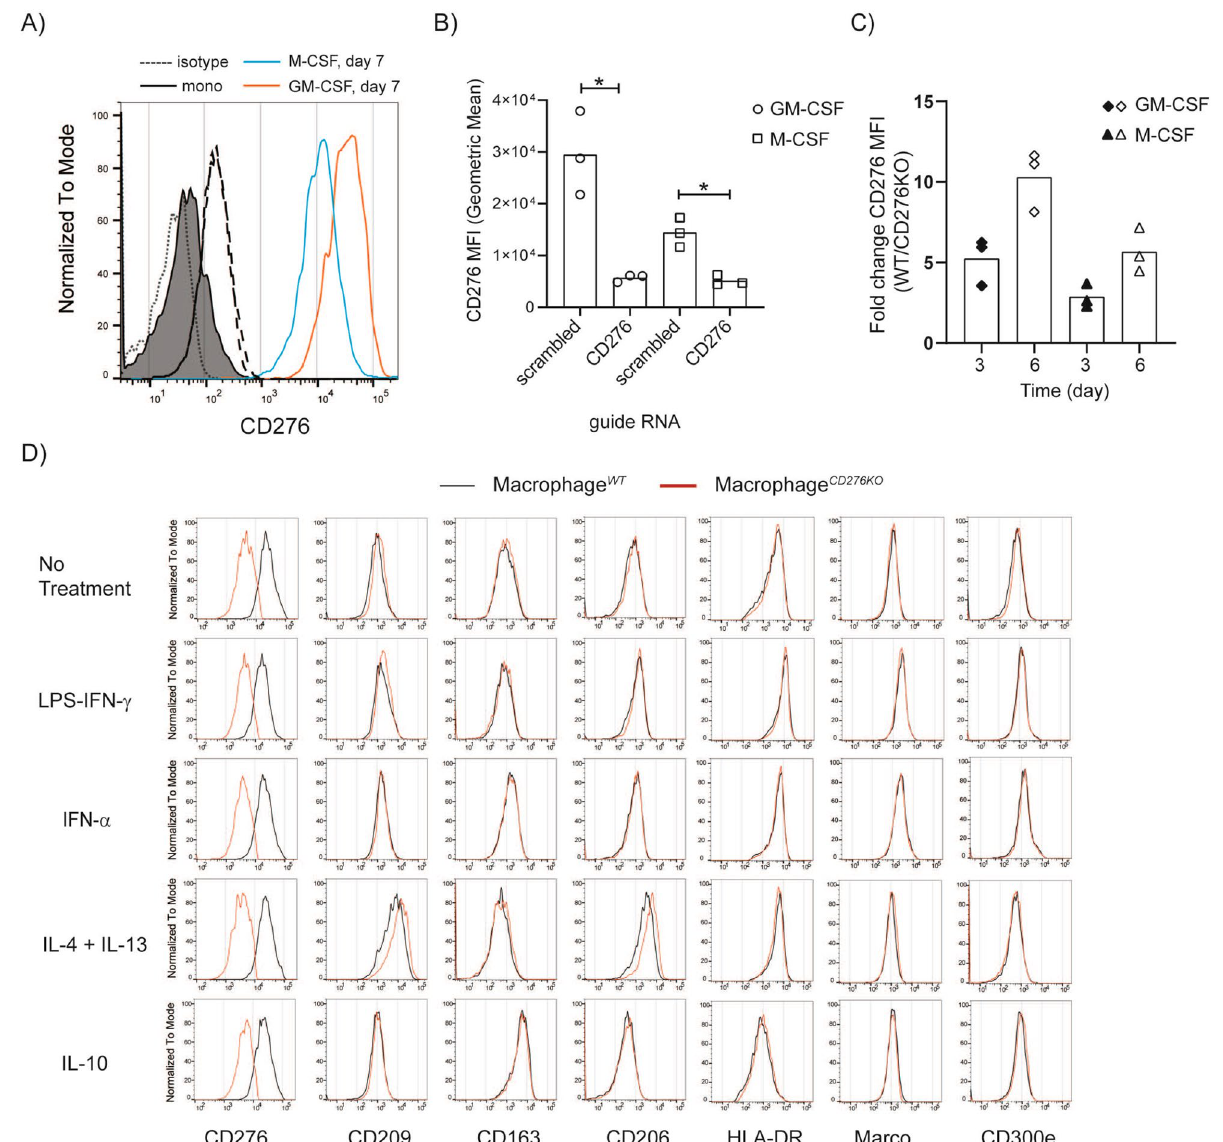
Figure 2. Monocyte to macrophage differentiation induces CD276 upregulation, yet lack of CD276 expression on macrophages shows no impact for further polarization. (A) CD276 expression was analyzed on freshly isolated monocytes (day 0) and monocyte-derived macrophages (MDMs/Macrophages) cultured for 7 days by flow cytometry. Black line, filled histogram: Monocytes; red line, open histogram: MDMs cultured in GM-CSF supplemented medium; blue line, open histogram: MDMs generated in M-CSF supplemented medium; dotted/ dashed lines for day 0/7: isotype control. The histogram shows one representative donor out of four donors. ( B-D) MDMs (M-CSF) were genetically edited with Crispr-Cas9 technique either with scrambled gRNA (Macrophage WT ) as control or CD276-specific gRNA (Macrophage CD276KO ). ( B) The graph summarizes the mean fluorescence intensity (MFI, geometric mean) of CD276 on MDMs 3 days after gene editing. Statistical analysis was done with paired t -test * p < 0.05. ( C) CD276 expression on MDMs was compared from day 3 to day 6 after gene editing by flow cytometry. The graph depicts the ratio of CD276 MFI on Macrophage WT to Macrophage CD276KO on indicated time points in GM-CSF or M-CSF supplemented condition. ( D) 3 days after gene editing, MDMs (M-CSF) were further treated with indicated stimuli for 24 h and analyzed for indicated surface markers by flow cytometry. Red line: Macrophages CD276KO ; black line: Macrophages WT . These histograms represent one representative donor out of three